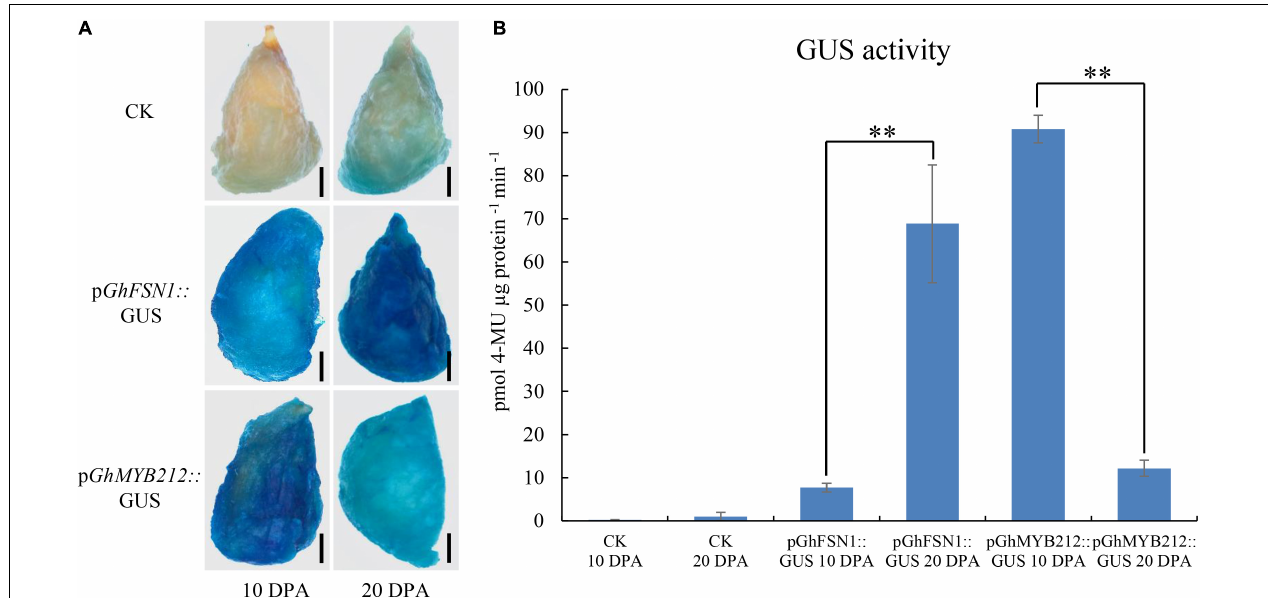
FIGURE 5 | Activities of promoters of GhFSN1 and GhMYB212 at different fiber development stages were analyzed via Agrobacterium -mediated transient transformation. (A) GUS staining results showed that the GhFSN1 promoter had high activity at 20 DPA fibers, while the GhMYB212 promoter had high activity at